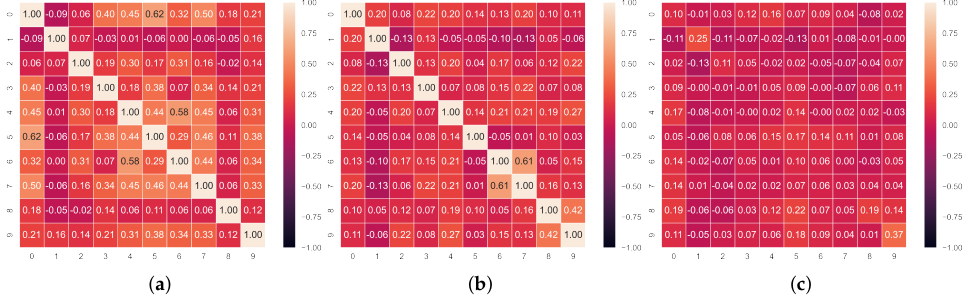
Figure 5. Correlation matrices between the honest and/or faked items in the JIHO dataset. ( a ) Corre- lation matrix of faked responses. ( b ) Correlation matrix of honest responses. ( c ) Correlation matrix of honest and faked